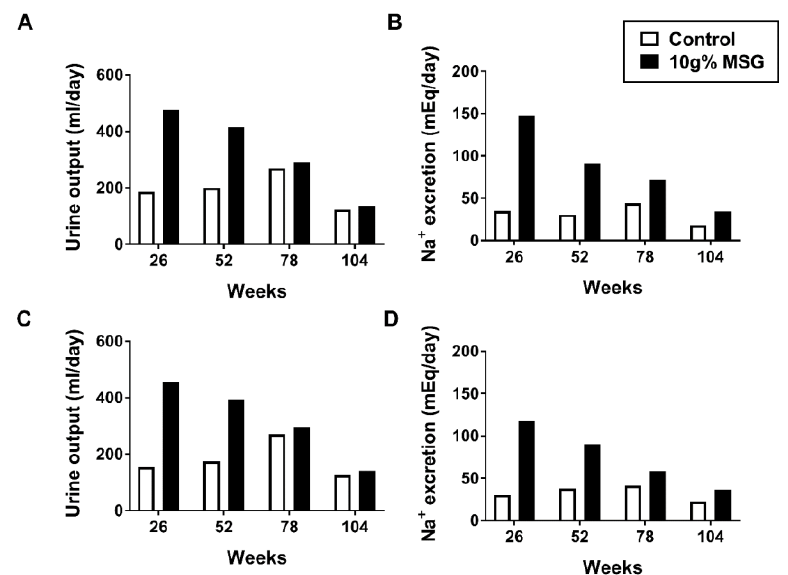
Figure 2. Urine output and sodium excretion in dogs fed with 10 g% MSG for 2 years compared to the controls, modified from Owen et al., 1978 [17]; ( A ) urine output ( B ) sodium excretion in male compared to control groups ( n = 5, each), ( C ) urine output ( D ) sodium excretion in female compared to control groups ( n = 5, each).